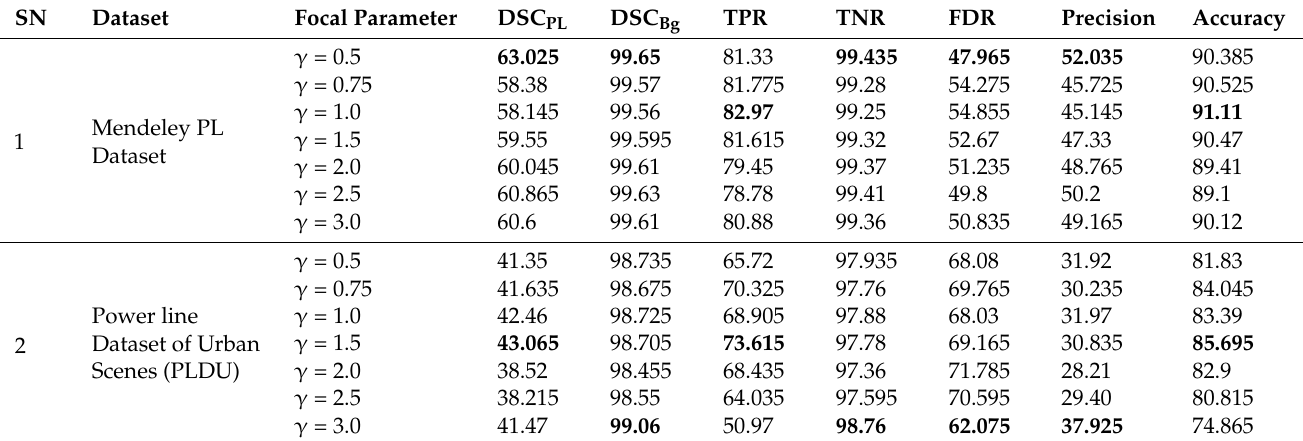
Table 2. Experimental results of the proposed focal Phi loss (FPL) on the Mendeley PL and PLDU validation datasets with ACU-Net. DSC: dice score; TPR: true positive rate; TNR: true negative rate; FDR: false detection